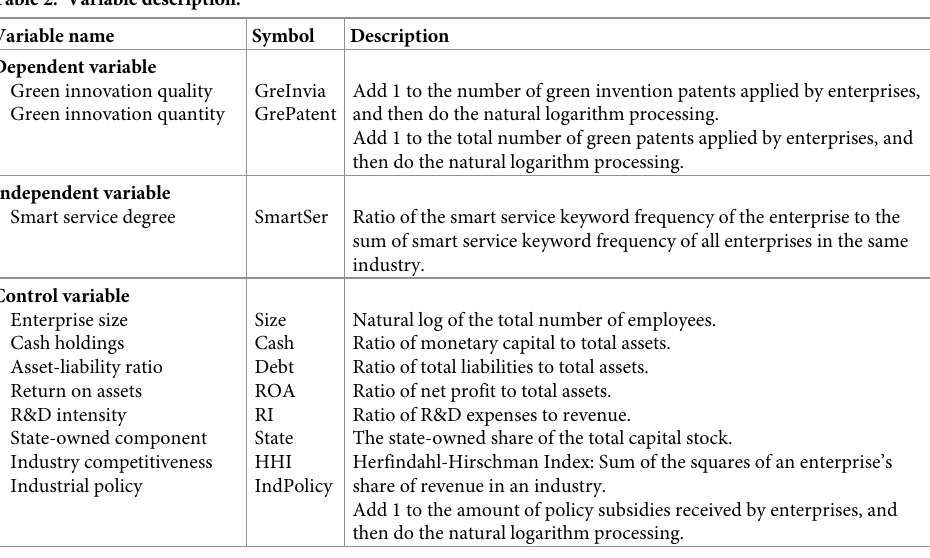
Table 2. Variable description.